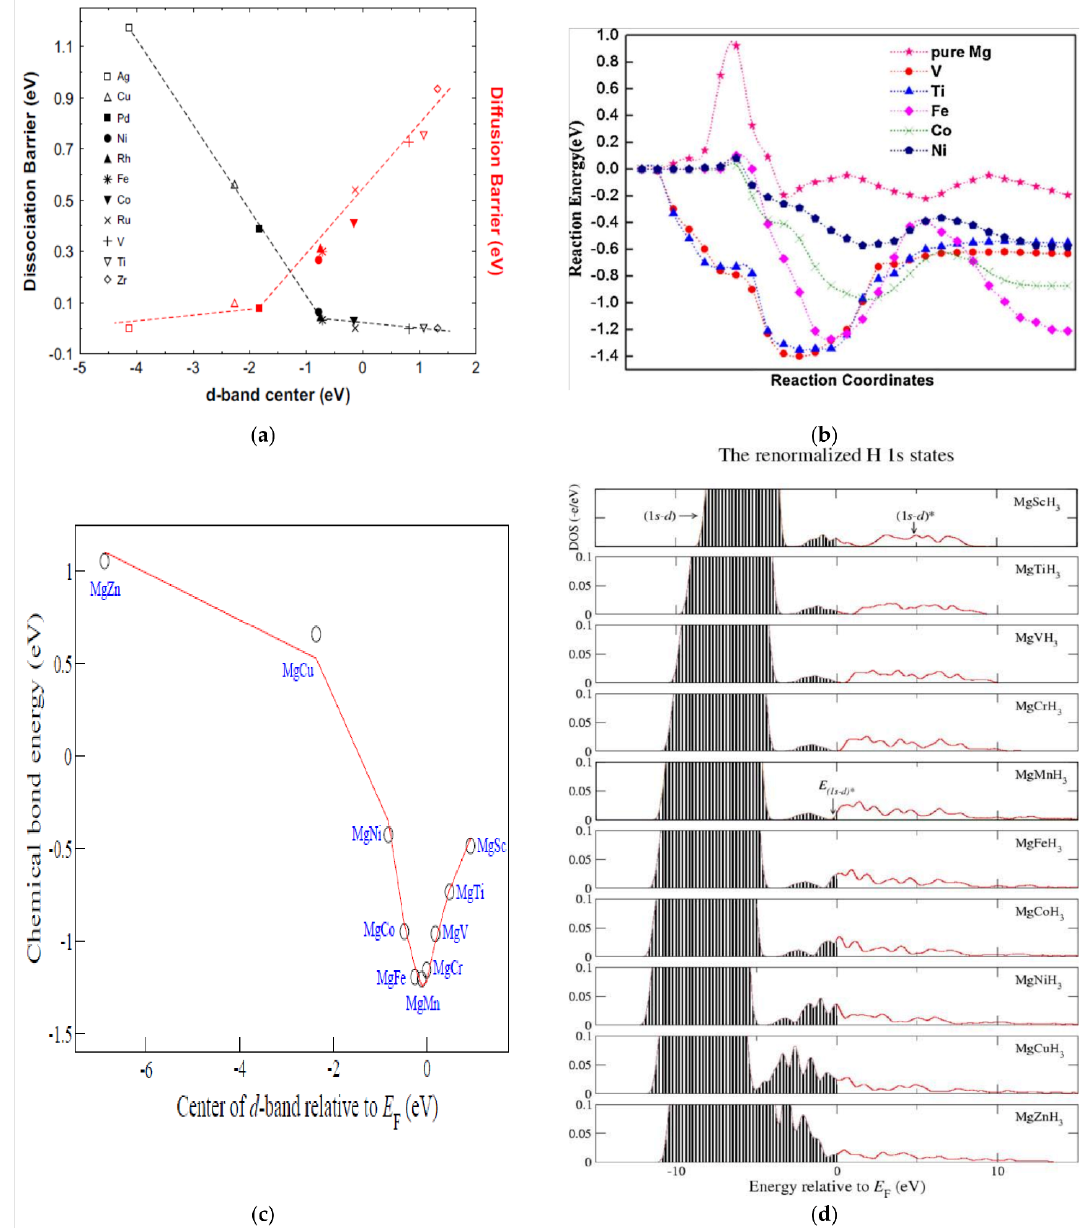
Figure 25. ( a ) Activation energy barrier for hydrogen dissociation (black) and diffusion (red) of hydrogen on pure Mg and TM-doped Mg(0001) surfaces (TM is not capped by the kicked-out Mg atom) as a function of the d band center positions. Reproduced with permission [211].